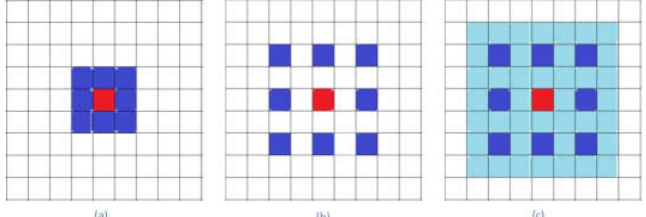
Figure 1. The receptive field of the first two level modules of the atrous convolution group: (a) Receptive field of the first level of the group, a 3 × 3 kernel atrous convolution function module rated 1. (b) Receptive fields of the second level of the group, a 3 × 3 kernel atrous convolution module rated 2. (c) Receptive field of the first and second level modules combined.